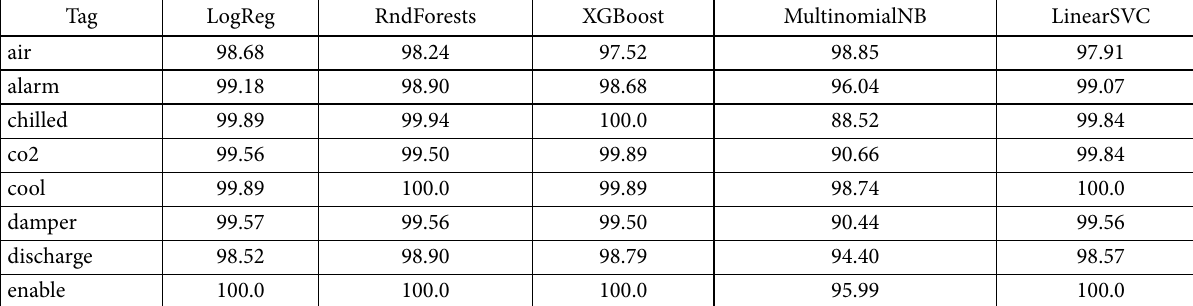
Table 7. Results of applying five techniques to the individual tags, % of accuracy per tag type. Bold font denotes the algorithm which produced the highest score for each tag type